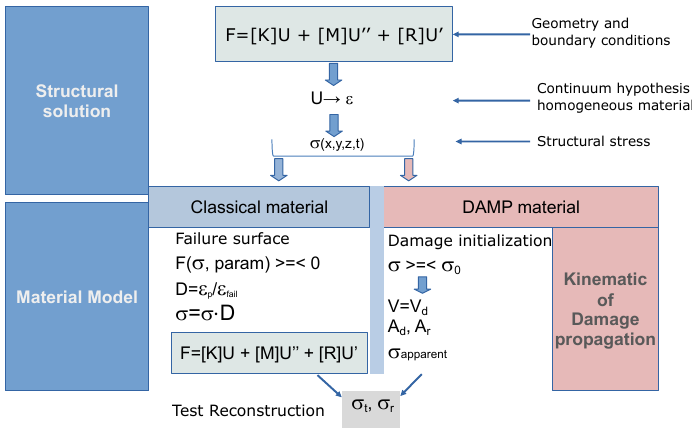
Figure 4. Equation flow to compute structural solution with classical material model and damage propagation (DAMP) material